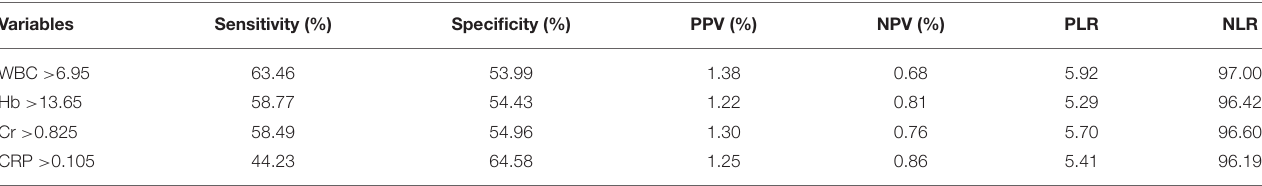
TABLE 4 | Performance parameters of predictors of acute stroke in the study